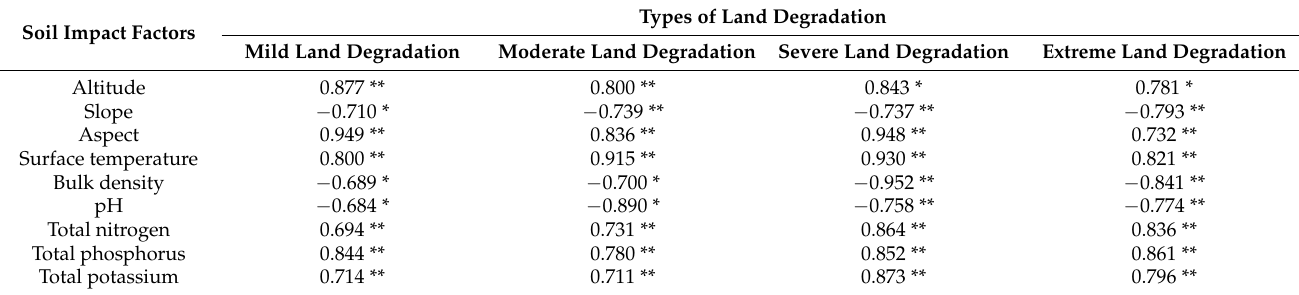
Table 4. Correlations between SOM and influence factors for soil with different land degradation